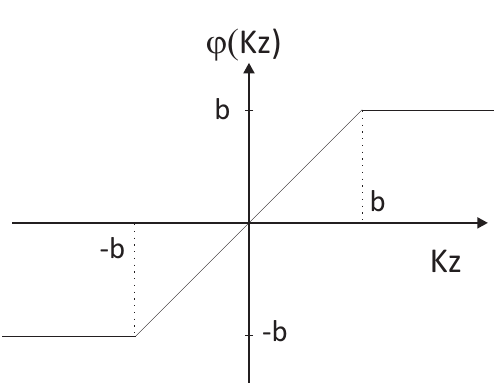
Figure 4. Huber’s